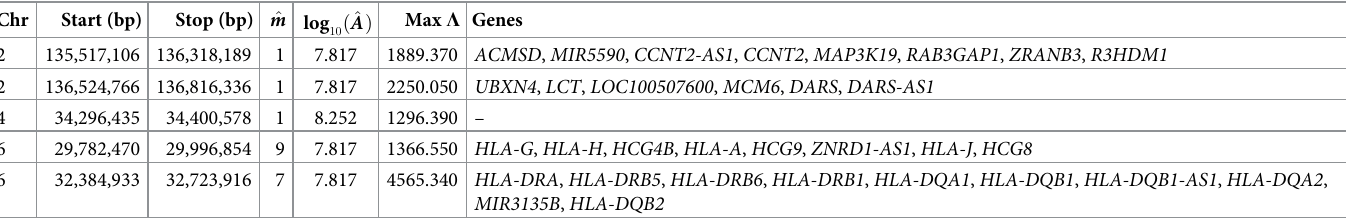
Table 1. Regions of extreme Λ values in the CEU population and the genes contained therein. ^ m is the inferred number of sweeping haplotypes, and log mated sweep width.